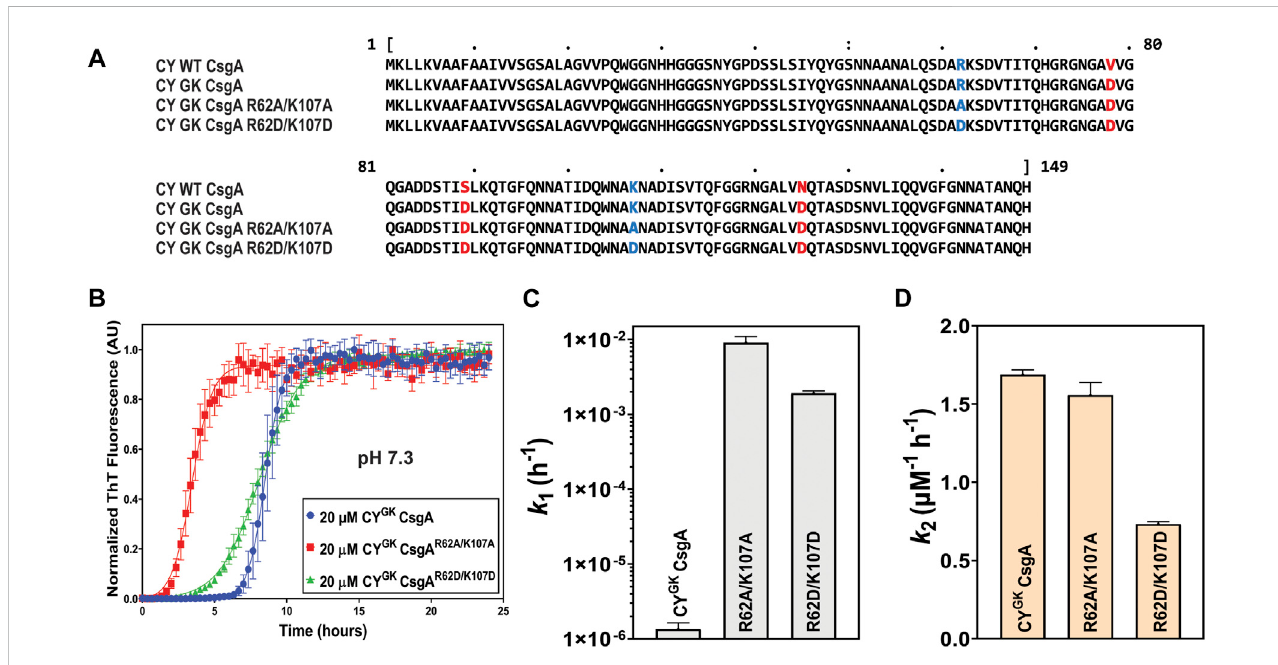
FIGURE 1 Gatekeeping function is affected by R and K residues. Analysis of aggregation kinetics of CY GK CsgA, CY GK CsgA R62A/K107A , and CY GK CsgA R62D/K107D at 37 ° C, pH 7.3. (A) Sequence alignment of wild-type CY CsgA, CY GK CsgA, CY GK CsgA R62A/K107A , and CY GK CsgA R62D/K107D with aspartic acid gatekeeper residues in red and mutated arginine and lysine in blue. Alignment was created using MView (https://www.ebi.ac.uk/Tools/msa/mview/). (B) Thio fl avin T (ThT) fl uorescence assayusing20 μ MofCY GK CsgA,CY GK CsgA R62A/K107A ,andCY GK CsgA R62D/K107D . (C) Nucleationrates k 1 ofamyloidosisonalogscaleand (D) Growthrates k 2 of amyloid fi ber propagation on a linear scale. [Error bars represent Standard Error of Mean (SEM) for ThT assay and Standard Deviation (SD) for k 1 and k 2 of three